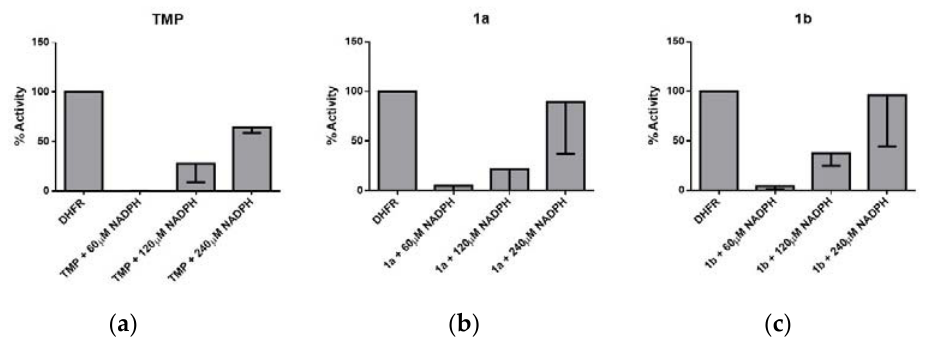
Figure 4. Activity (%) of E. coli dihydrofolate reductase (DHFR) after a 30-min incubation with substrate in the presence of the inhibitors ( a ) TMP, ( b ) 1a and ( c ) 1b , each at a concentration of 5 µ M, and different concentrations of NADPH. The data are expressed as a percentage with respect to the control.